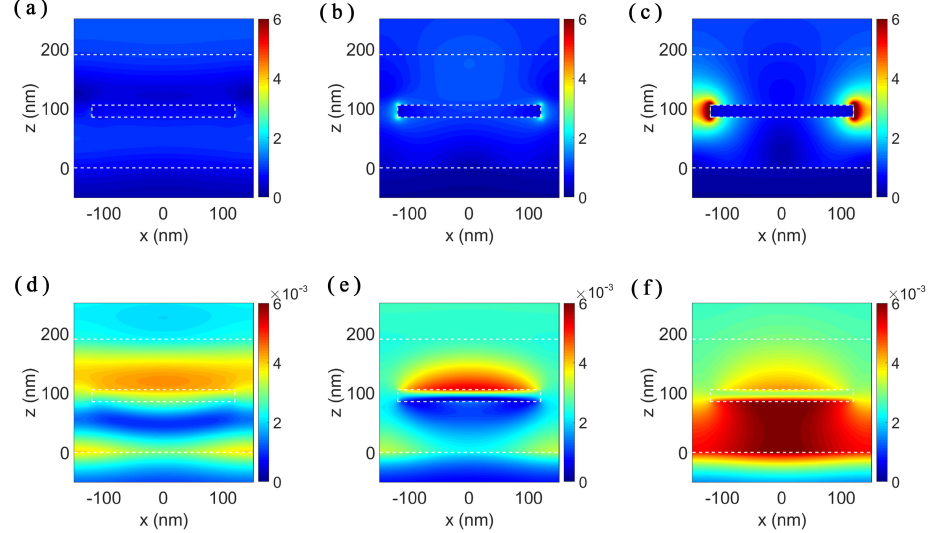
Figure 5. Electric ( a – c ) and magnetic ( d – f ) field distributions of the SiO 2 /patterned-TiN/SiO 2 /TiN structure in the x-z plane at wavelengths: ( a , d ) 467.4 nm; ( b , e ) 787.6 nm; and ( c , f ) 1779 nm. The size parameters of the stacks are as follows: thickness of the top and bottom SiO 2 layer is 85 nm, the thickness of the patterned-TiN layer is 20 nm, the diameter of the TiN nanodisk is 240 nm and the period of the TiN nanodisk array is 300 nm. The white dashed lines outline the interfaces between different